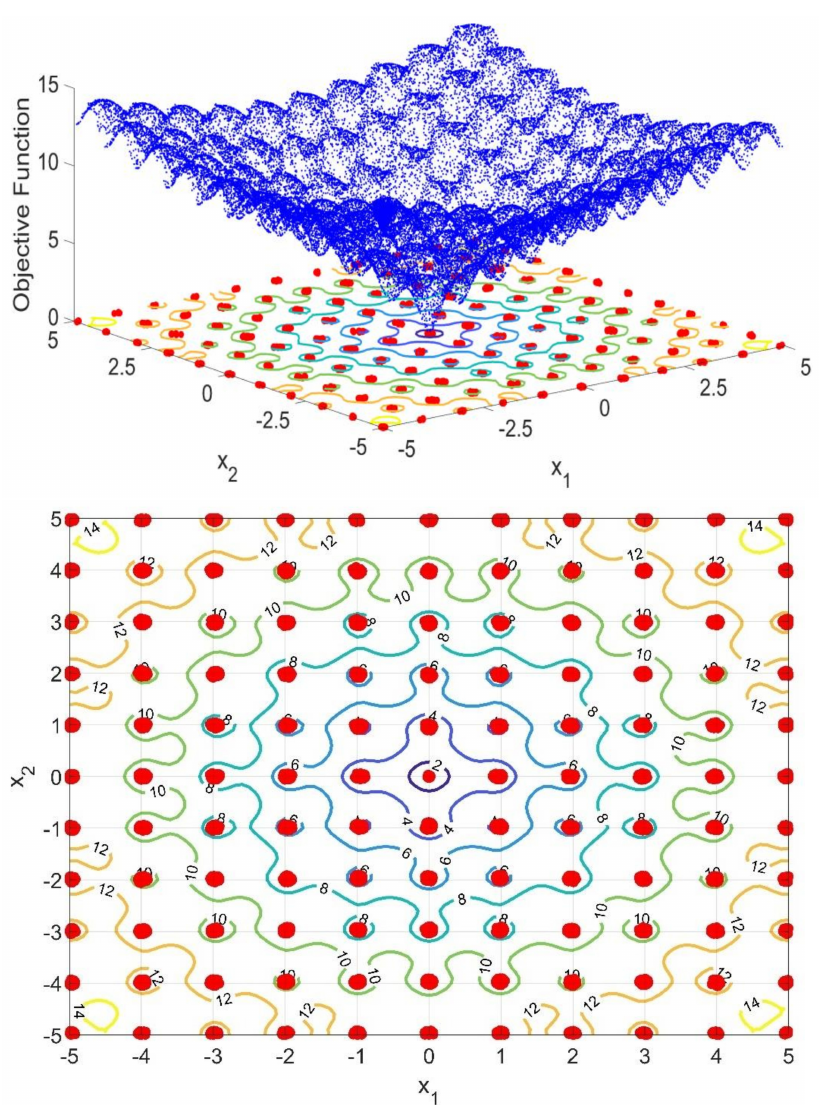
Figure 4. Ackley Function 3D topography drawn by the proposed CSPSO and its corresponding 2D map of the local and global minima, with the confidence regions drawn by the deduced likelihood test. It is also presented a surface map of the objective function in order to show the location and values of the minima and global